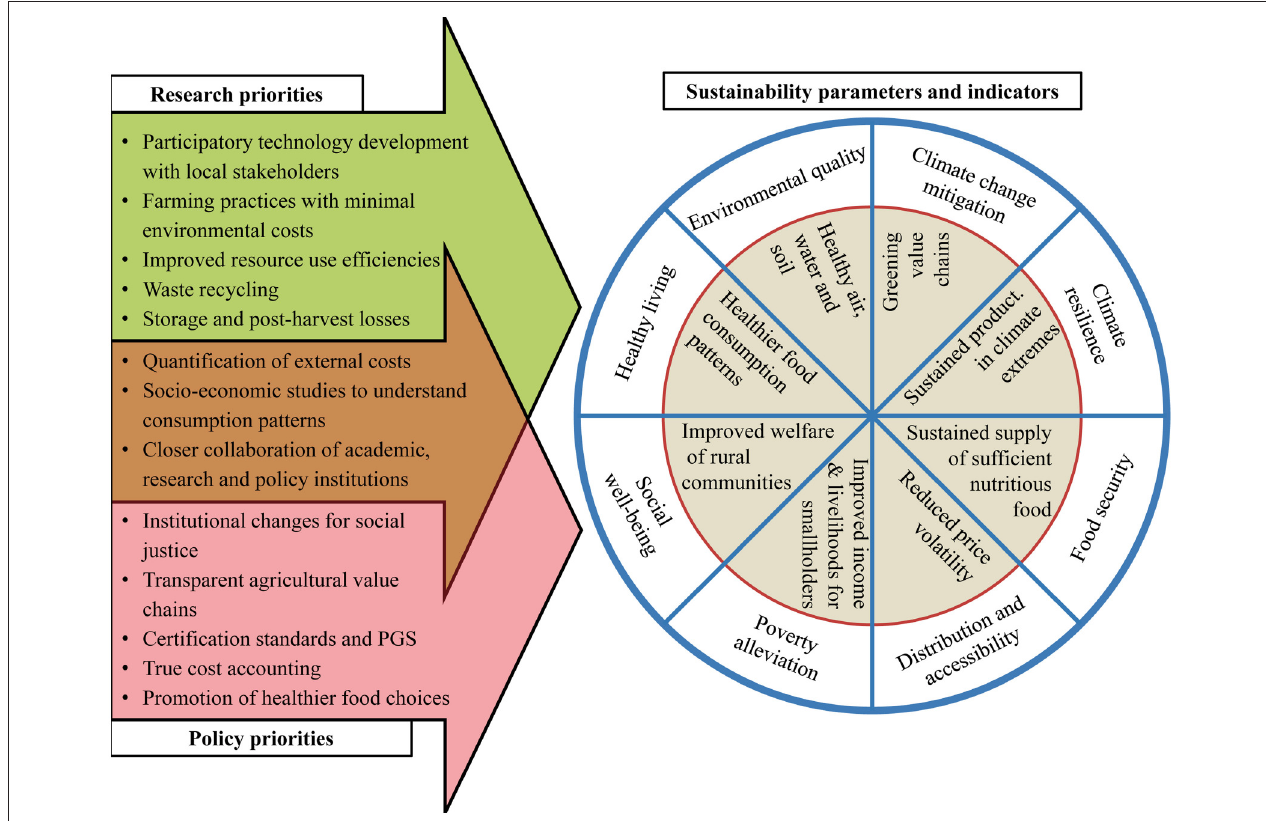
FIGURE 1 | Research and policy priorities for sustainable intensification of agro-ecosystems and supply chains. Inner red circle: sustainability indicators; outer blue circle: sustainability parameters.